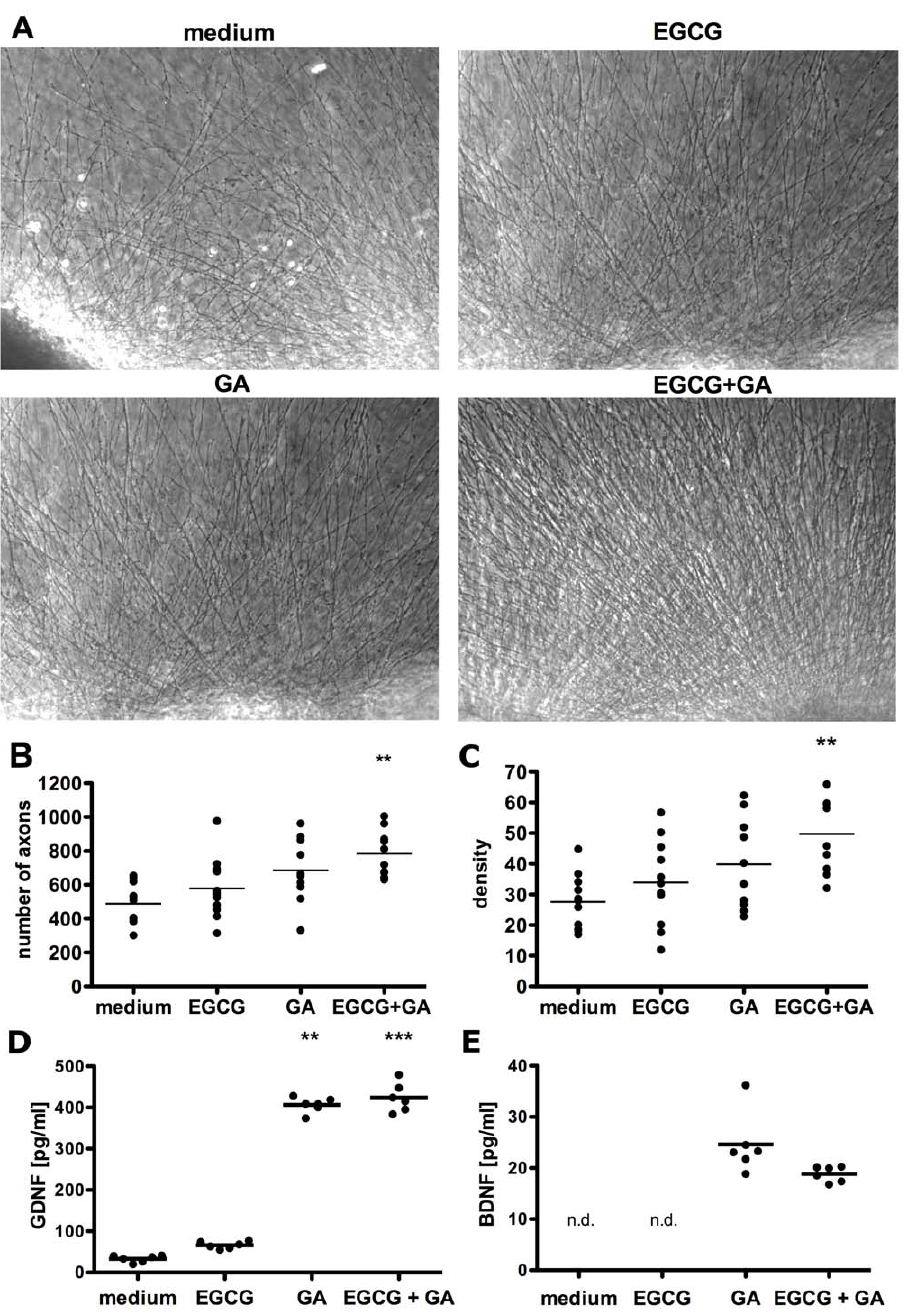
Figure 2. EGCG and GA promote axonal growth and density invitro . Representative photomicrographs of brain slices with axonal outgrowth after addition of EGCG (5 m g/ml), GA (6.25 m g/ml) and the combination of EGCG (5 m g/ml) and GA (6.25 m g/ml) are shown. 100 6 magnification, scale bar: 300 m m (A). The number of axons was measured by quantifying all intersections of axons with a standardized line parallel to the brain slice border, **p , 0.001 (B). The density of outgrowing axons was determined by measuring the mean intensity in a standardized area parallel to the brain slice edge, **p , 0.001 (C). Levels of GDNF (D) and BDNF (E) were measured in the supernatant of outgrowth assays by ELISA, n.d.=not detectable. **p , 0.001 ***p ,